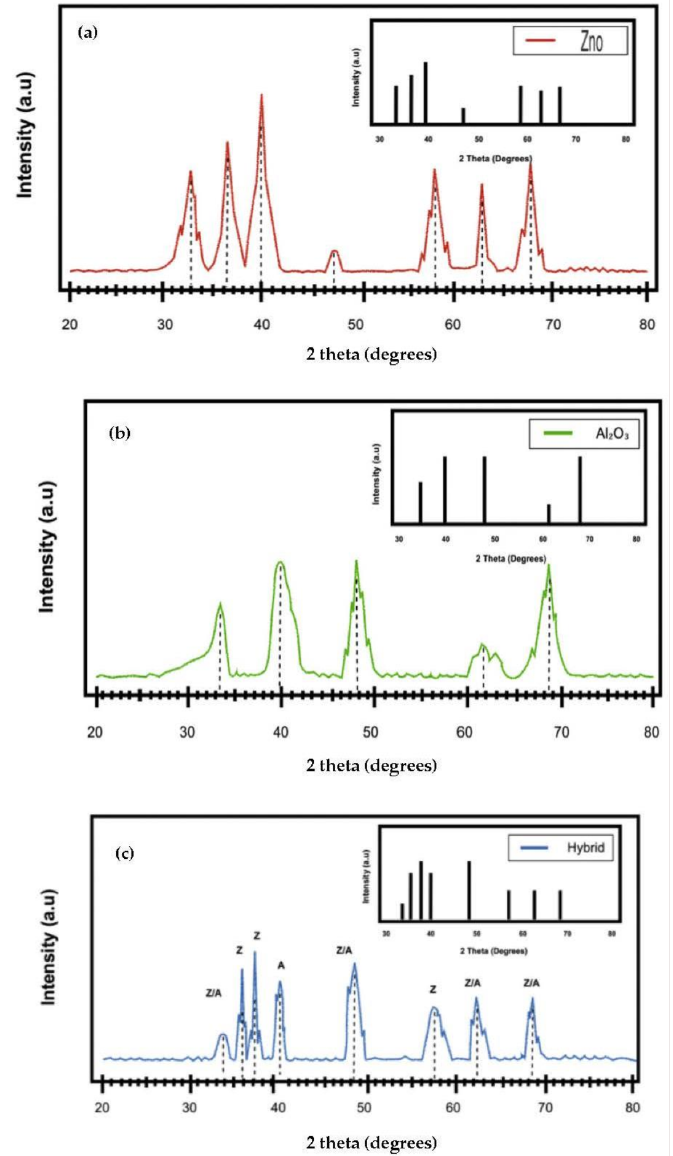
Figure 1. XRD characterization for ZnO, Al 2 O 3 , and Al 2 O 3 -ZnO water